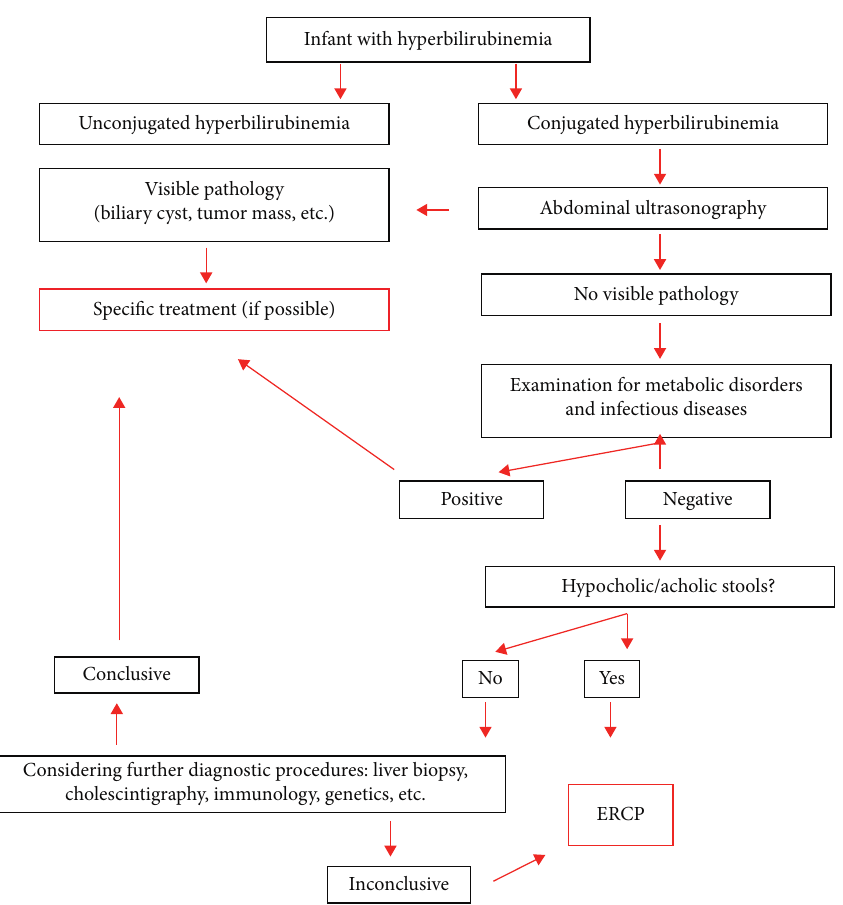
Figure 1: Diagnostic algorithm for conjugated